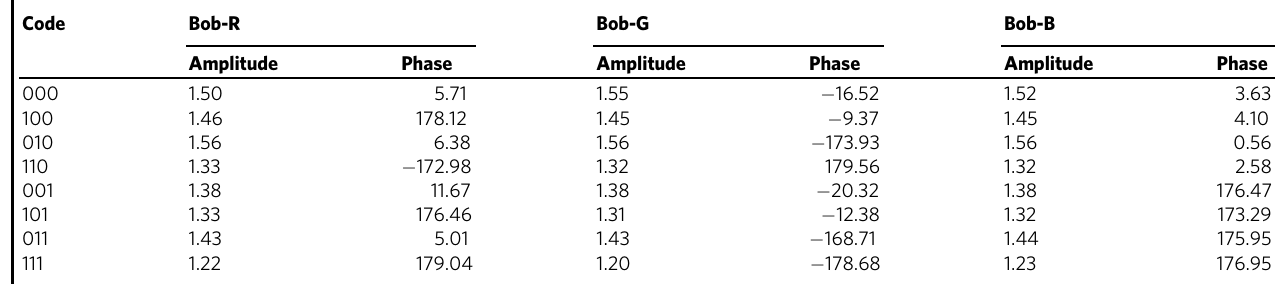
Table 1 Experimentally measured amplitudes and phases on Bob ’ s side for the optimized eight different coding patterns. Code